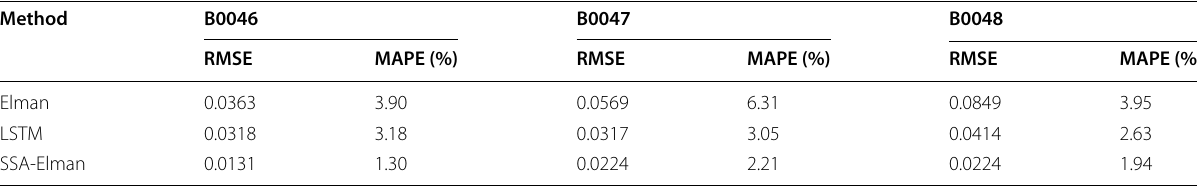
Table 10 Estimation errors at low